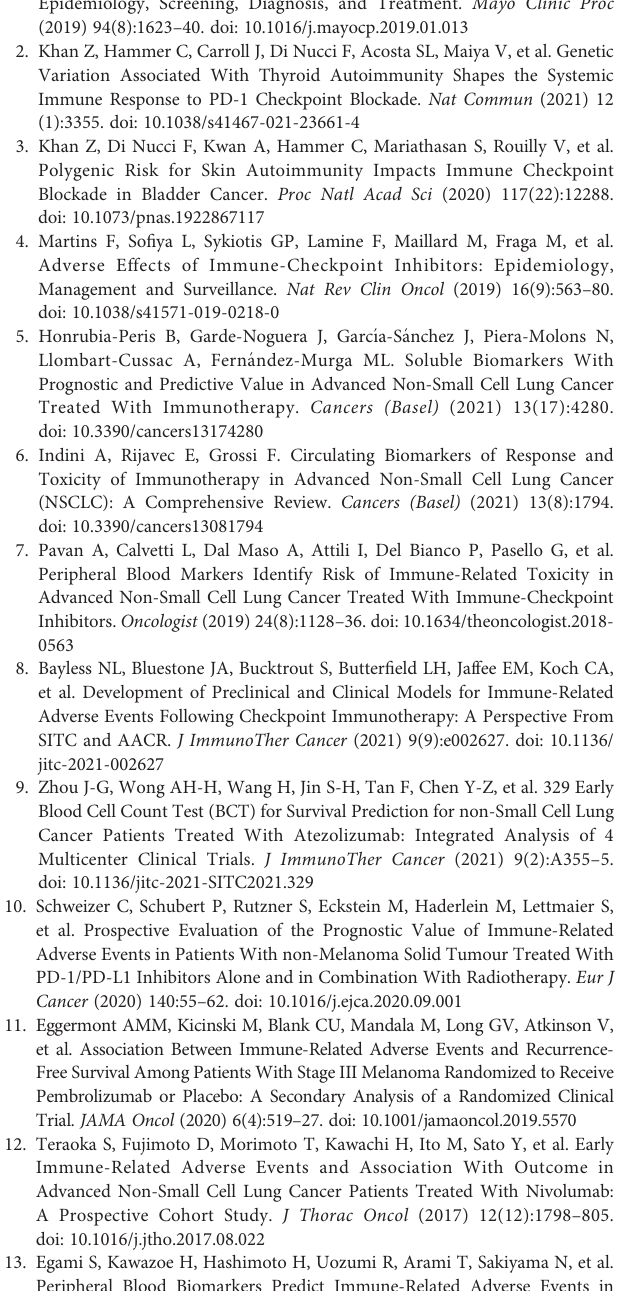
Supplementary Table 3 | Summary of assay performance. Sensitivity, speci fi city, accuracy, and the kappa statistic were computed for the 7 machine learning methodsfrom1,000 simulationsof thetraining andtest datasetsat8:2,7:3 and 6:4 cohort ratios randomly selected from the combined cohort comprising 1,320 atezolizumab-treated NSCLC